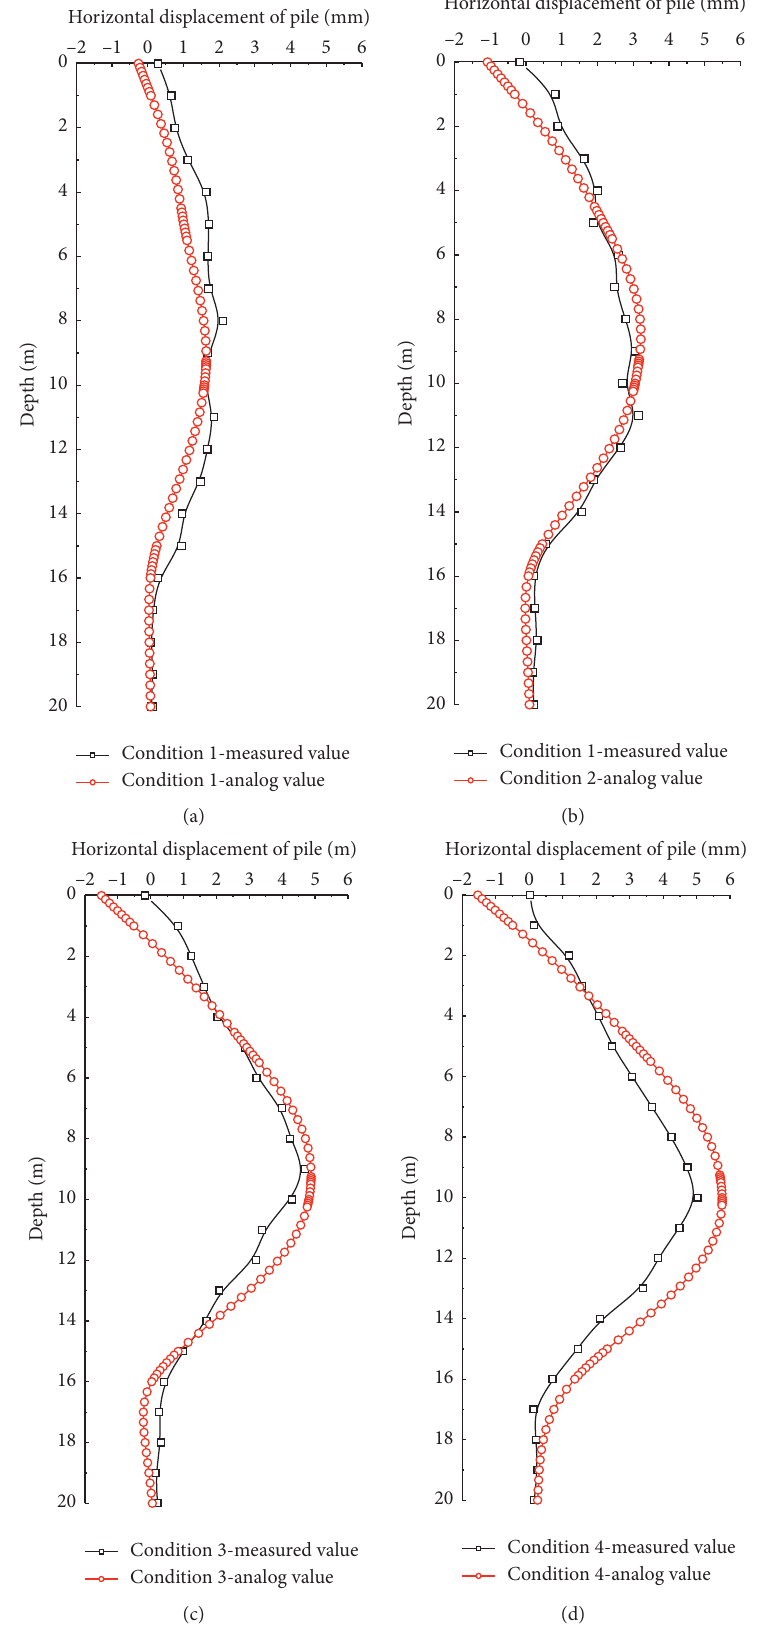
Figure 4: Horizontal displacement of pile under different working conditions. (a) Condition 1. (b) Condition 2. (c) Condition 3. (d) Condition